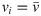
Activation parameters and H in independent model.(a) Scatter plot for H when vi ∈ [10, 104] (asterisks) and when vi=v¯ for i = 1, 2, ⋯, n (solid curve) for different values of n. (b) H vs CV(v) for different values of n. (c) Heat map showing the proportion of times H increased with increasing vi as a function of n and d for vi ∈ [10, 104] and ki = 1 with 1000 simulations of randomly chosen vi ∈ [10, 104].